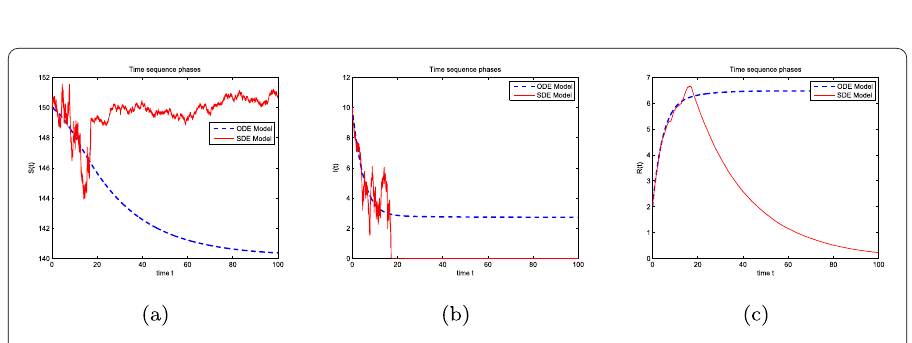
Figure 2 Dynamical curves of compartments: ( a ) S , ( b ) I , and ( c ) R under R > 1 and R s <